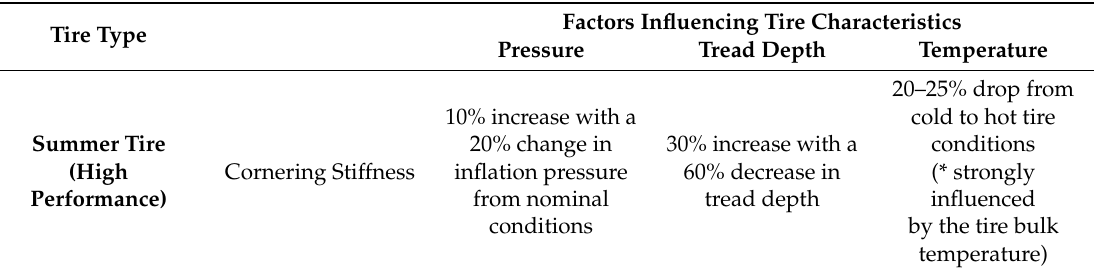
Table 6. Sensitivity